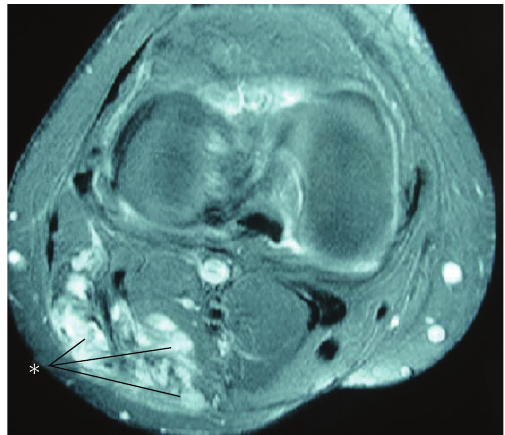
Figure 1: Axial image of MRI shows a large, expansive heteroge- neous soft tissue mass with contrast, closely applied to the muscular structures, and infiltration and obliteration of adjacent structures (white asteriks).